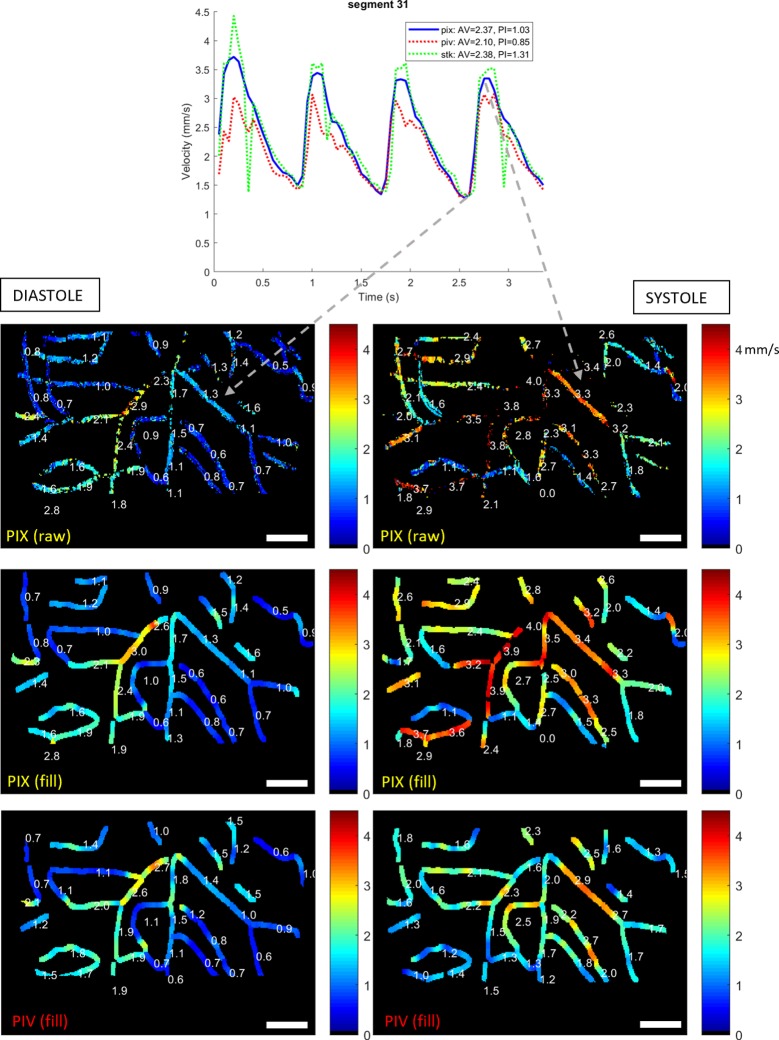
Spatial velocity maps comparing performance for slow and fast flow.Top: velocity trace used to infer phase of the cardiac cycle. Left column: presumed diastole. Right column: presumed systole. Sequence was acquired at 300 fps and can be viewed in S5 Video. Top plot confirms the phase of the pulse wave. Second row: PIX (raw). Third row: PIX (filled). Bottom row: PIV (filled). Physiological consistency across the network appears preserved in this sequence during systole with PIX, but not with PIV, which is unable to track the faster systolic flow. The legend shows, from left to right, the average velocity (AV), the pulsatility index (PI, defined as (max-min) / mean), the R2 goodness of fit to manually tracked data, and the root-mean-square (RMS) residual error to manually tracked data. Scale bars show 50 μm.